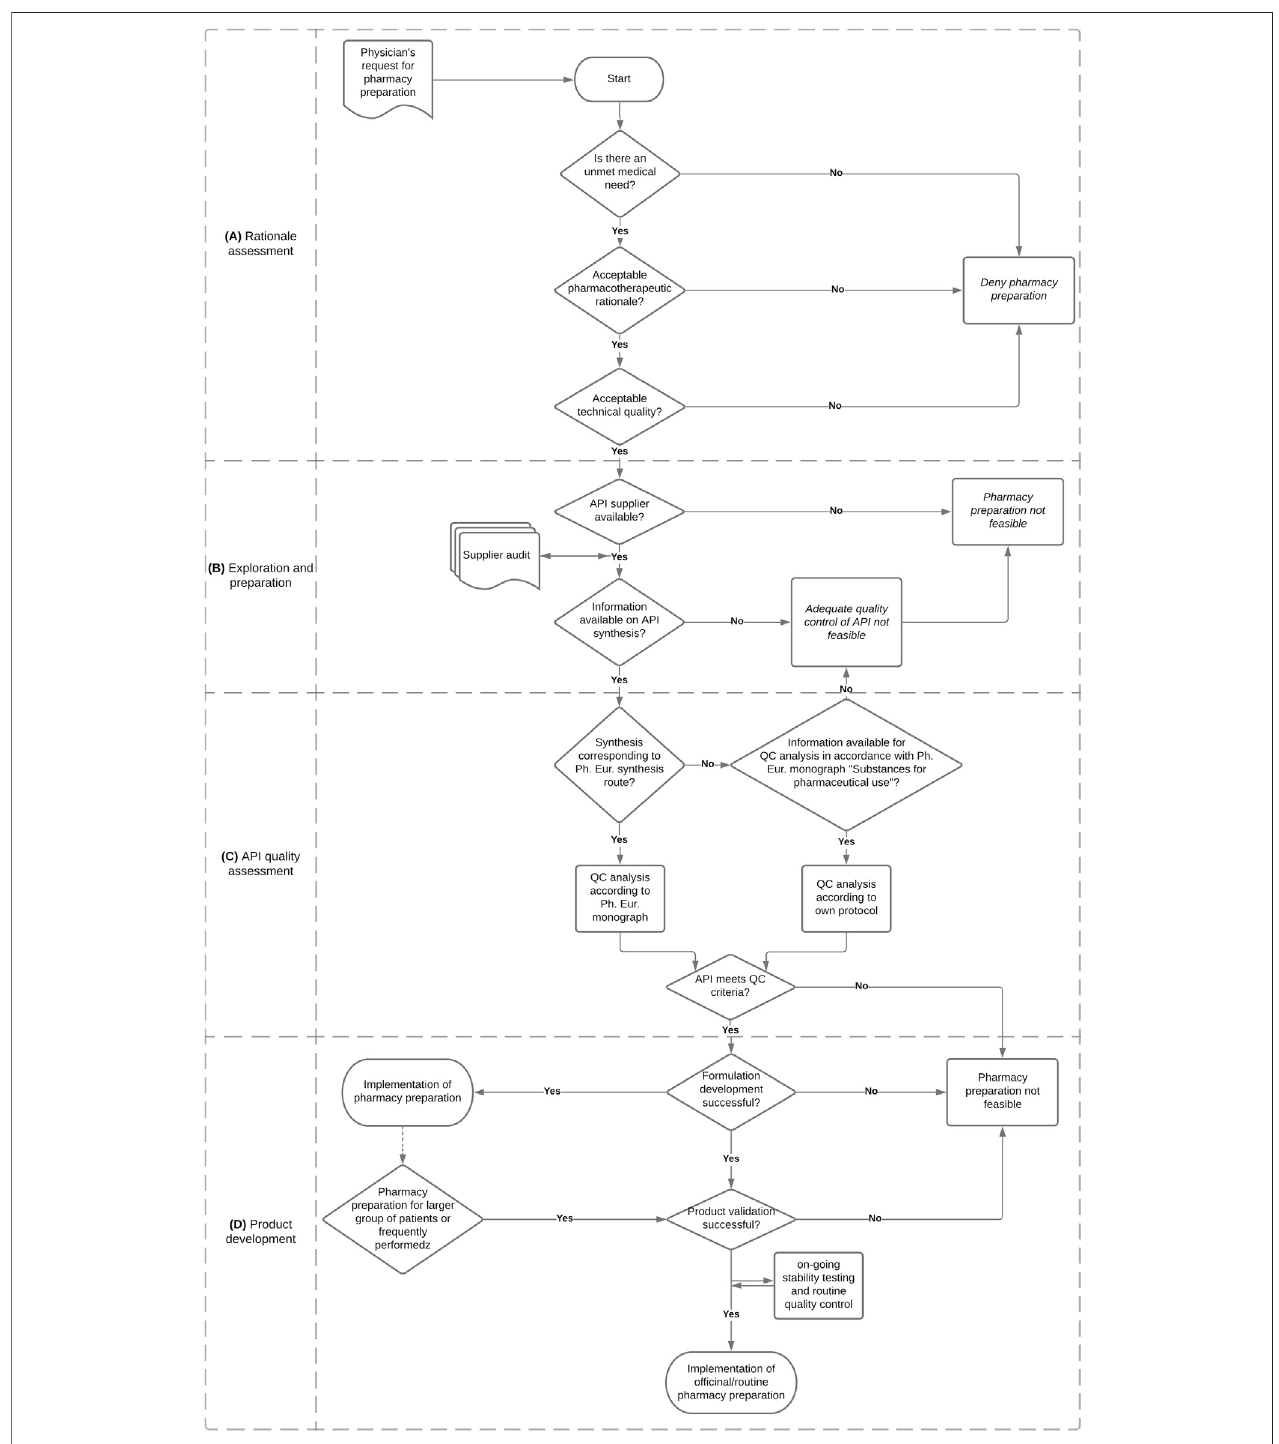
FIGURE 1 | Flowchart for the development and implementation of a pharmacy compounded formulation.